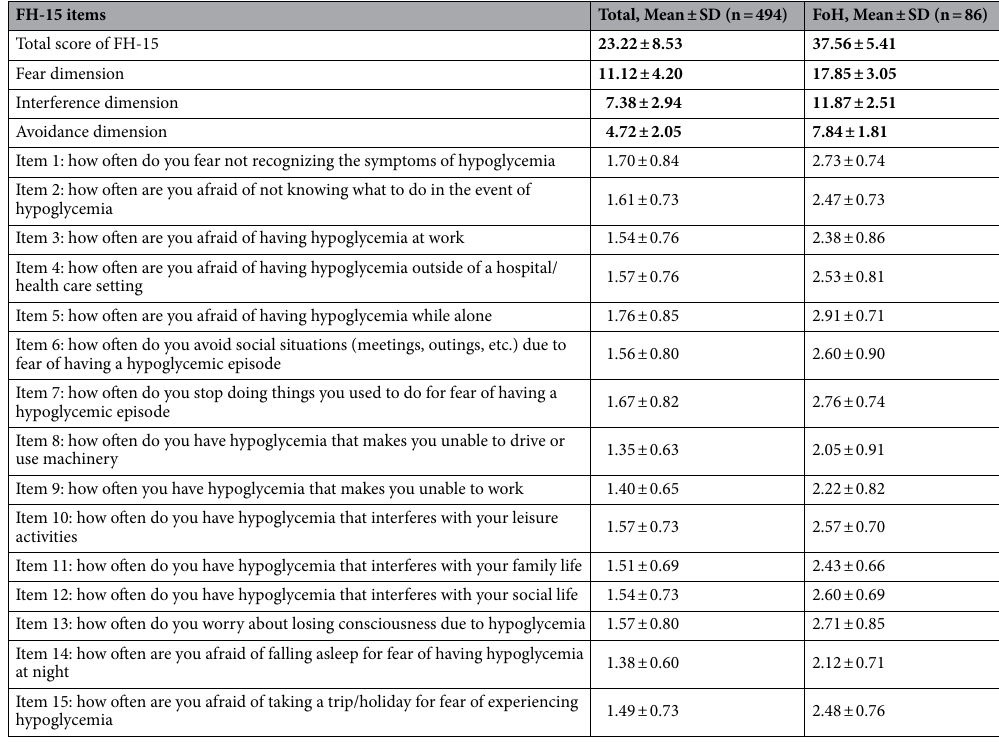
Table 4. Fear of hypoglycemia in patients with type 2 diabetes. FoH: fear of hypoglycemia; SD: standard deviation; FH-15: Fear of Hypoglycemia-15